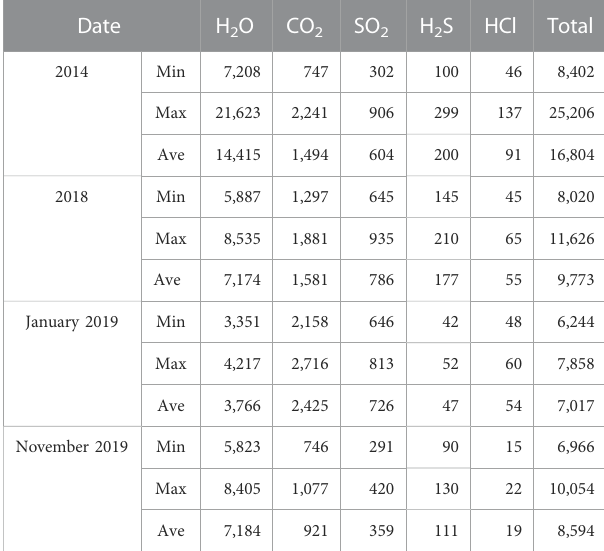
TABLE 6 Total volatile fl uxes and fl uxes for each gas specie in t/d. Minimum (min), maximum (max) and average (ave) fl uxes are